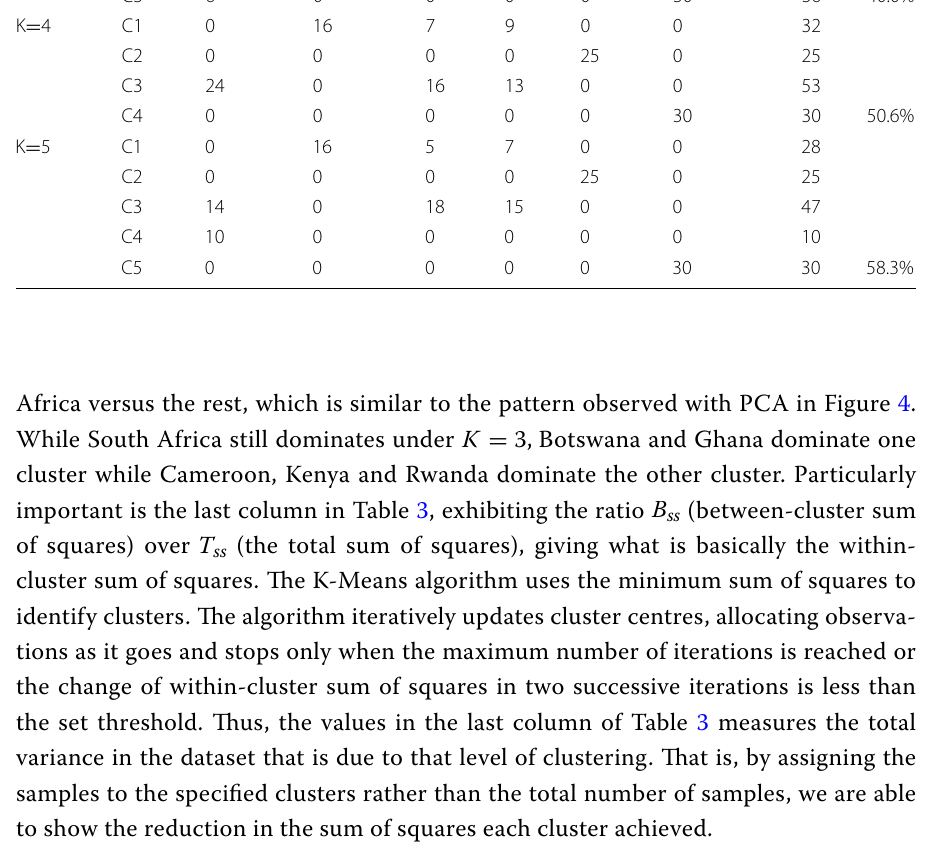
Table 3 Country-by country participation in the formation of